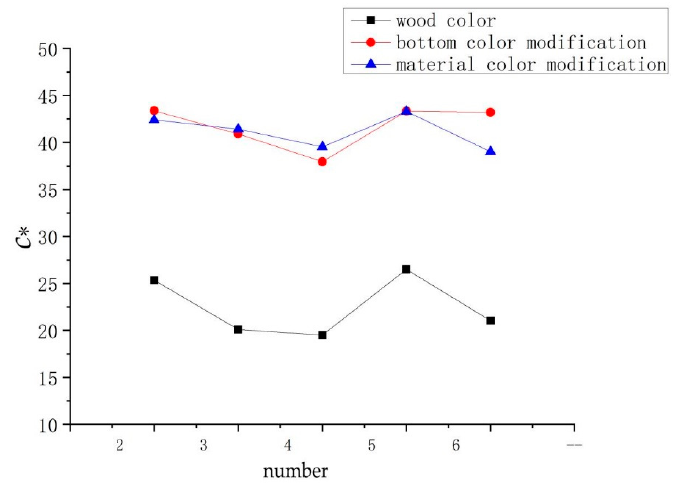
Figure 8. The effect of different surface disposition to C *. In summary, it can be seen that the colorant and coloring steps will have an impact on the color difference between modified poplar and mahogany. The colorant in this experiment is a reddish dye. The accumulation of color can reduce the difference in brightness and the red–green axis chromaticity index; that is to say, the coloring process can narrow the coloring effect of modified poplar and mahogany.